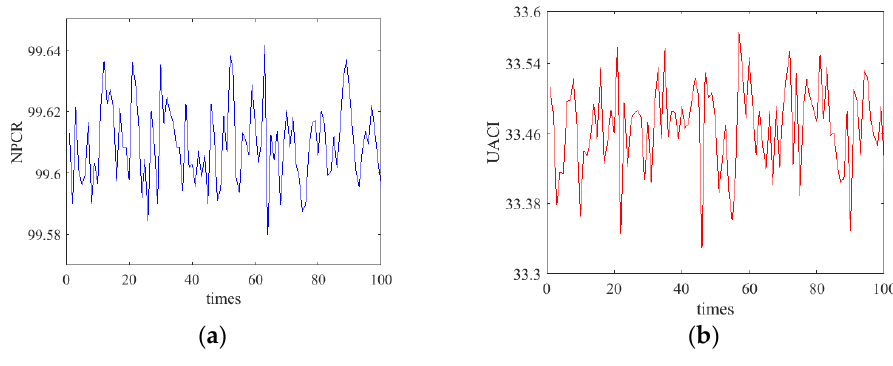
Figure 13. Differential attack test, ( a ) NPRC, ( b ) UACI.